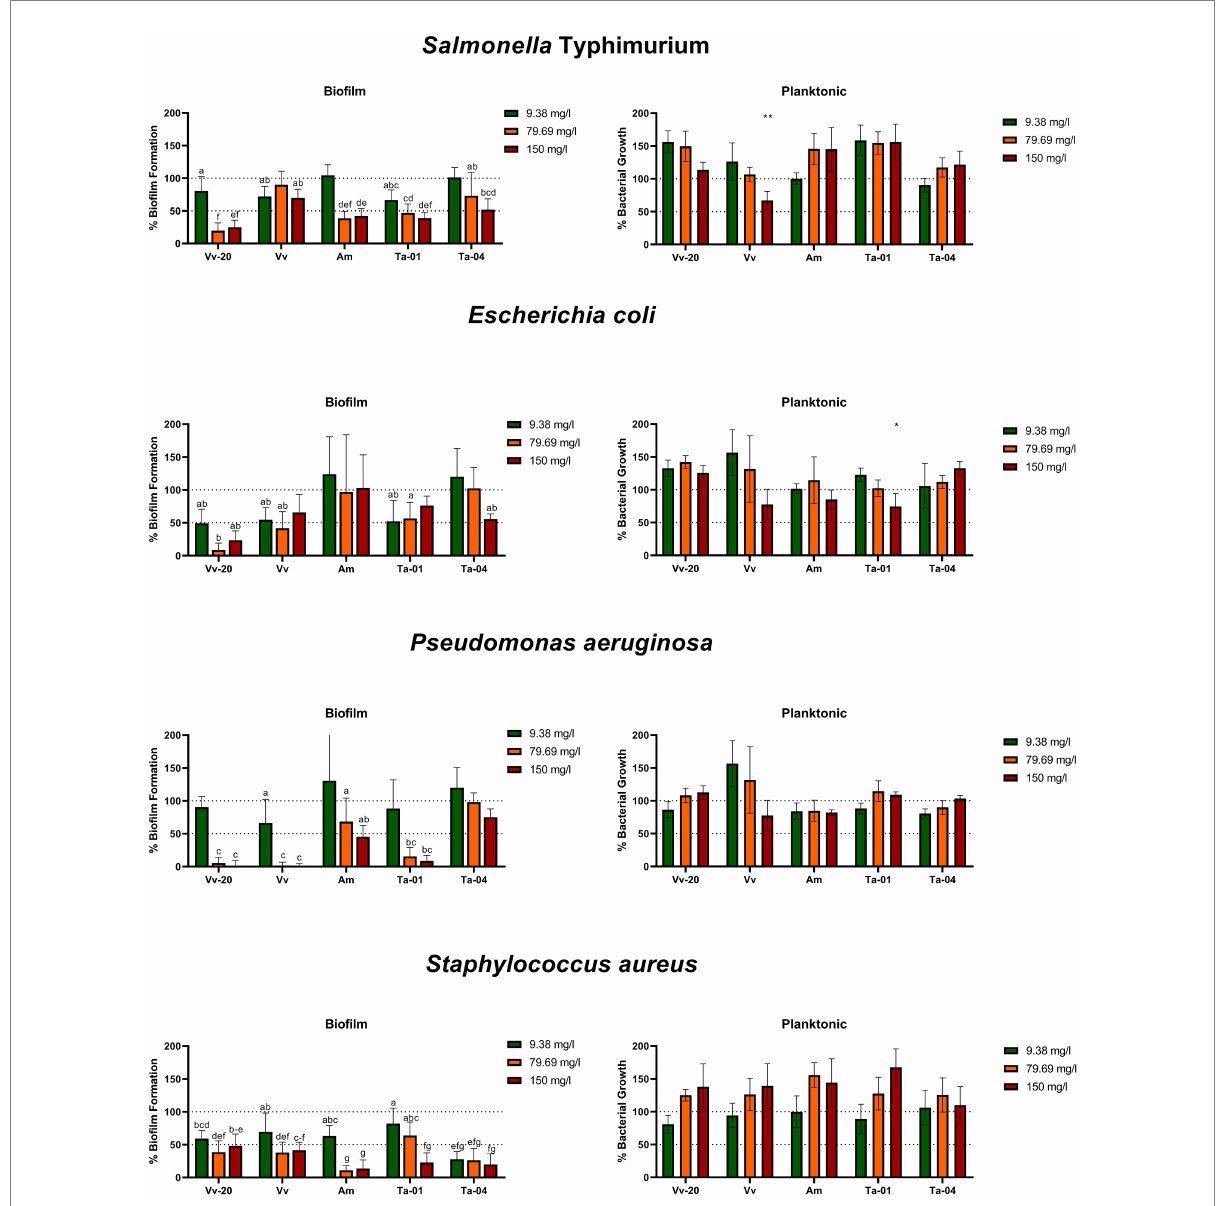
FIGURE 2 Biofilm formation and planktonic growth of the assayed bacteria (expressed as percentage in comparison to control) in the presence of 9.38, 79.69, and 150 mg/L of unmodified tannins. The letters in the biofilm formation graphs indicate groups of tannin-concentration combinations whose effects are significantly different from the control but not significantly different to each other; the bars with no letter are those tannin- concentration combinations which are not significantly different from the control. Asterixis in the planktonic growth graphs indicate a significant difference from control, * = p < 0.05; ** = p < 0.01. The statistical differences were determined via ANOVA test with Tukey post-hoc analysis, with a p -value of